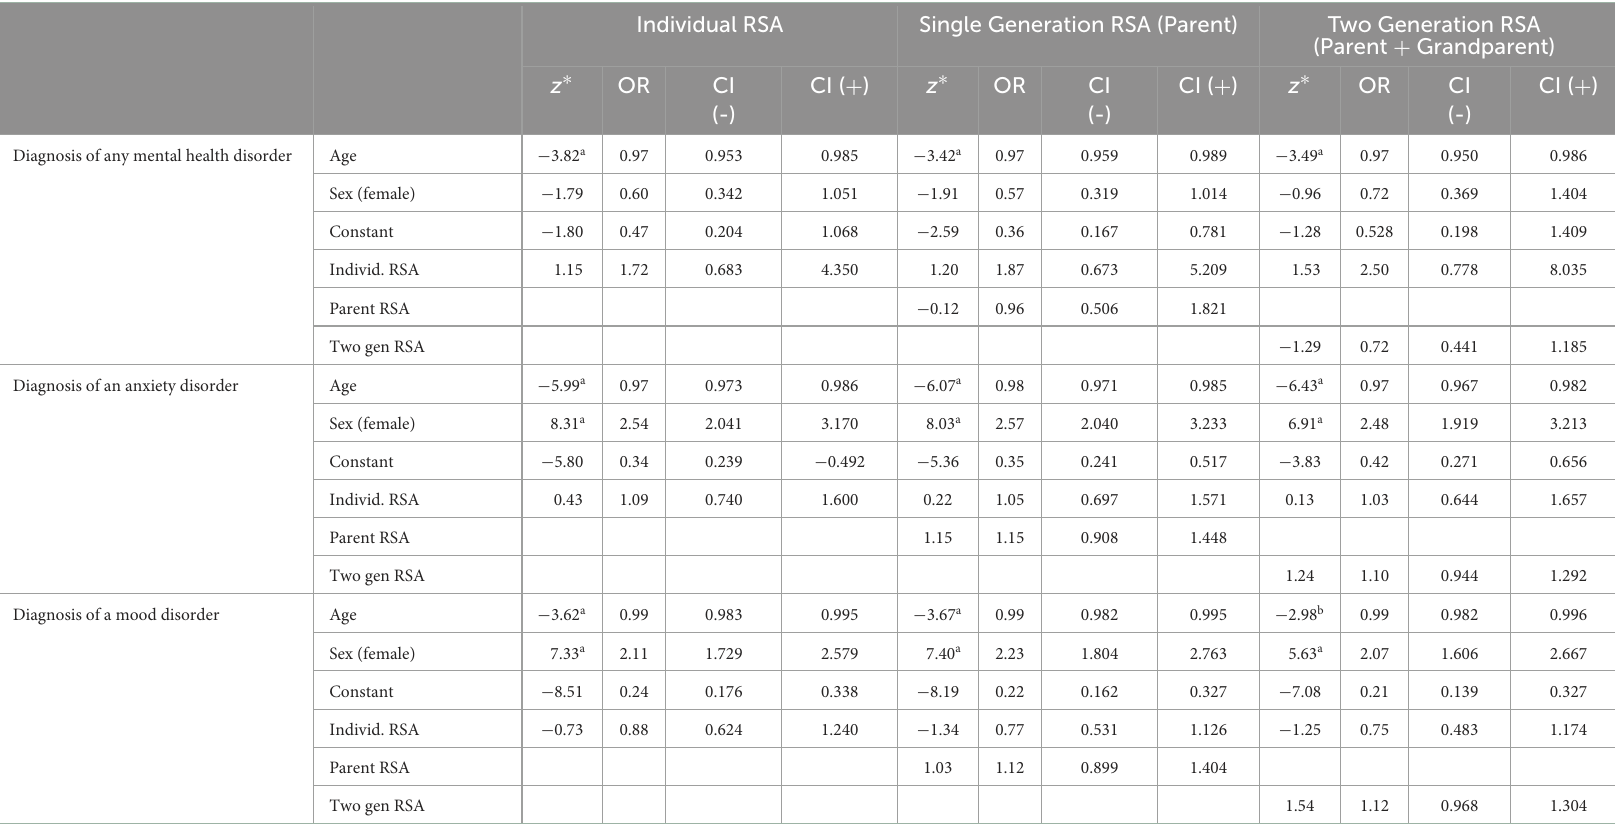
TABLE 4 Predictors of mental health disorder diagnoses including individual, parent, and two-generation RSA. Individual RSA Single Generation RSA (Parent) Two Generation RSA (Parent +